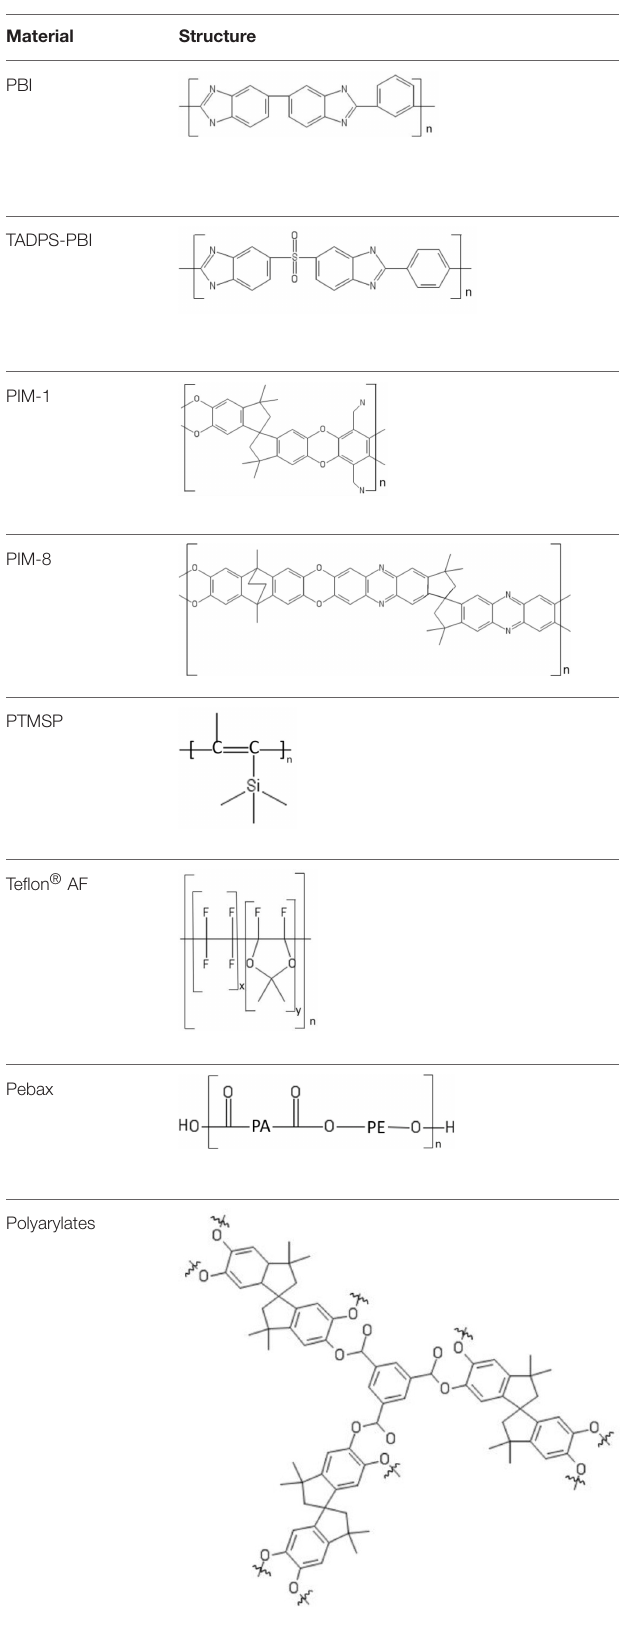
TABLE 2 | New materials for OSN application.